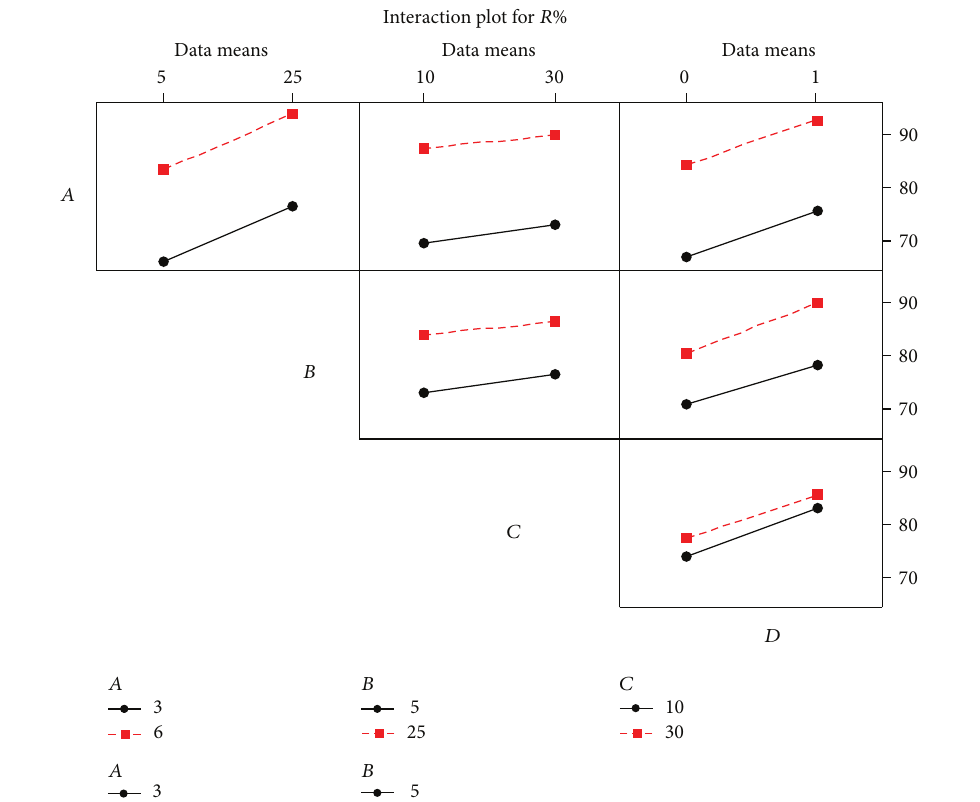
Figure 3: Interaction effects plot for removal